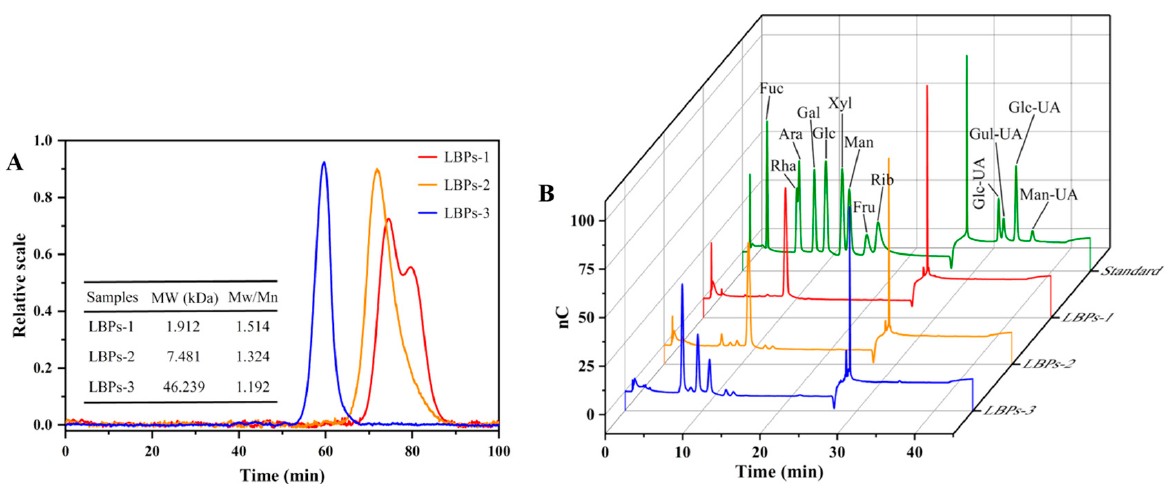
Figure 3. HPSEC-RID-MALS chromatogram of molecular weight ( A ) and HPAEC-PAD chromatograms of monosaccharides ( B ) of LBPs with three different molecular weights.